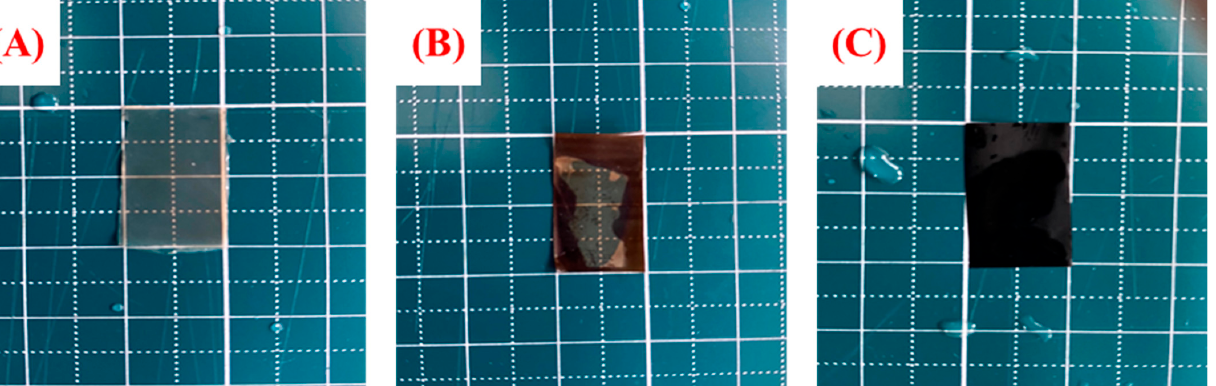
Figure 4. Changes in appearance of BAEMs after impregnation with 1 M KOH solution: ( A ) QA–PPO/PVDF(2/8), ( B ) QA– PPO/PVDF(3/7), and ( C ) QA–PPO/PVDF(4/6).